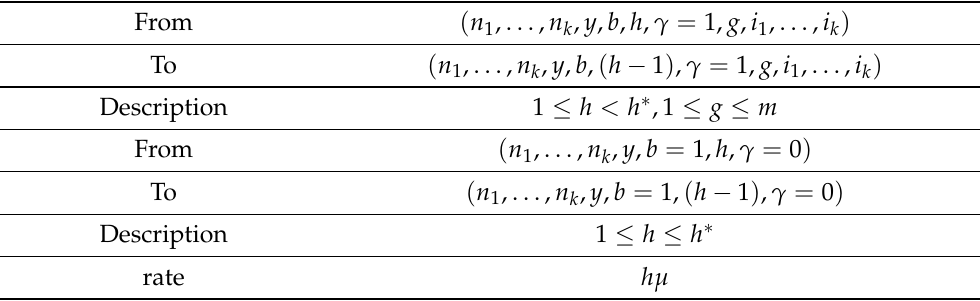
Table 3. Departure rate for